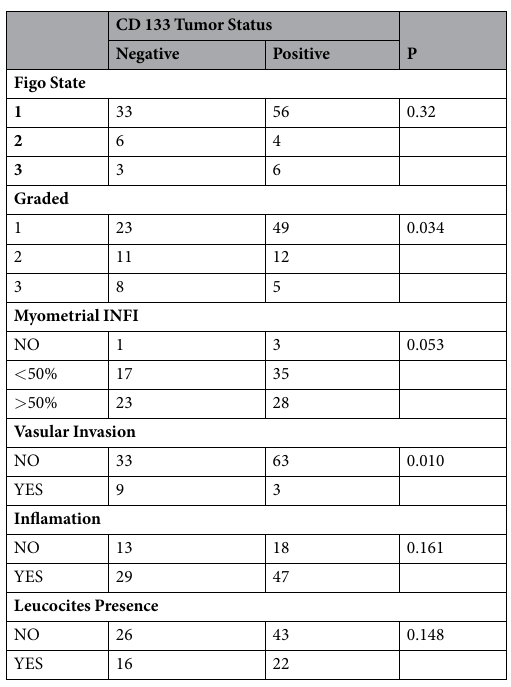
Table 2. CD133 Tumor Status and pathological parameters (n: